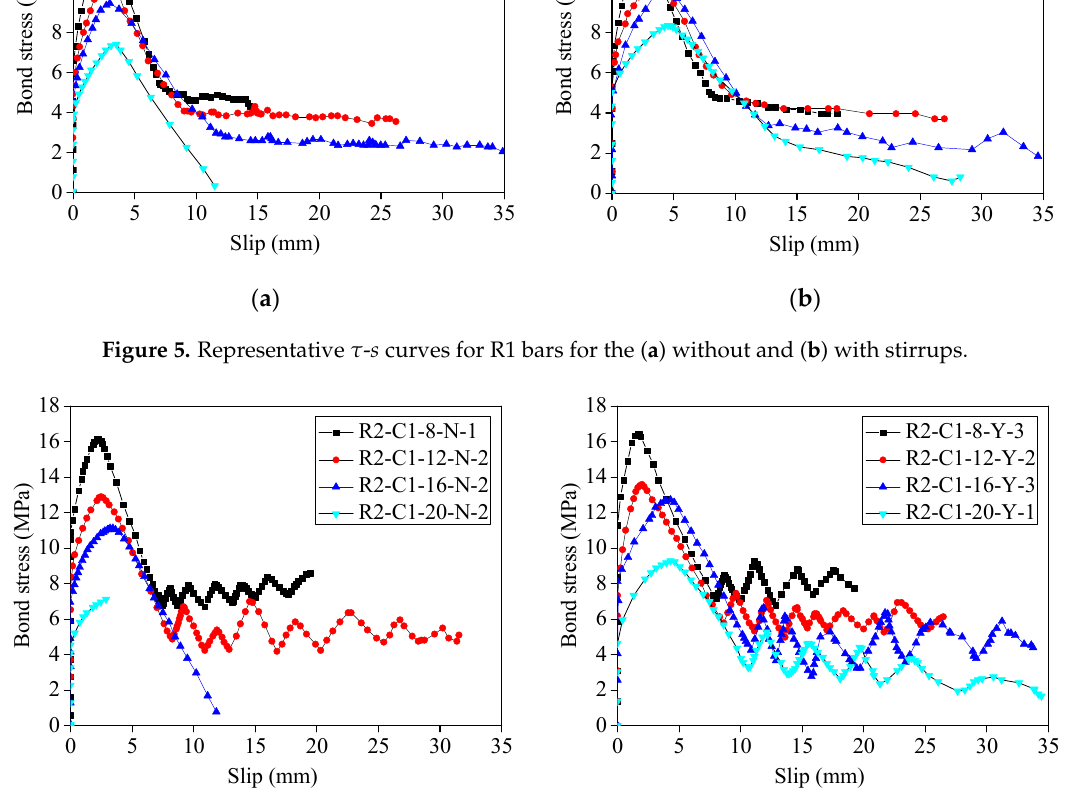
Figure 6. Representative τ - s curves for R2 bars for the ( a ) without and ( b ) with stirrups.